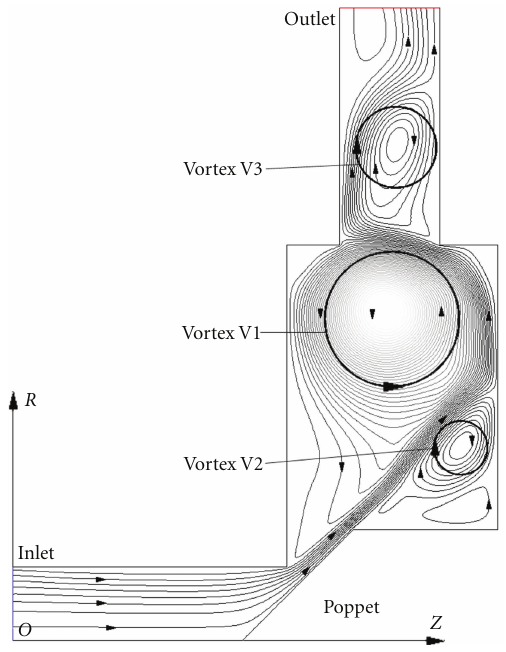
Figure 7: Streamline pattern in the meridian half-plane for a poppet valve with 28 mm inlet diameter, 45 ◦ poppet cone angle, and 5,6mm poppet displacement, operating at inlet/outlet pressure of